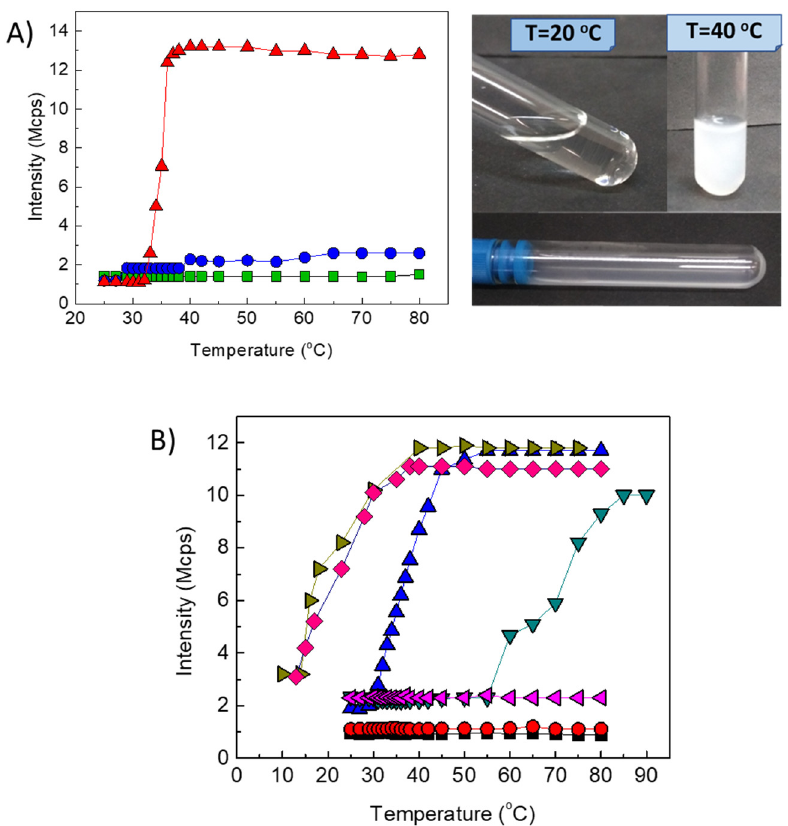
Figure 3. Light scattering intensity at 90 o as a function of temperature of PLL-g-NIPAm69 in aqueous solutions of various pH: ( A ) ( ∆ ) pH 11.8, ( ○ ) pH 9.5, ( □ ) pH 8.3, the photo illustrates a transparent solution at pH 11.8, at 20 °C and a cloudy one at 40 °C, which flows as a liquid (lowest image), and ( B ) in the presence of NaCl at various pH: 1M NaCl, pH ( □ )7.5, ( ○ ) pH 8,5, ( ◁ ) pH 9.1, ( ∆ ) pH 9.6, ( ▷ ) 9.8 and ( ∇ ) pH 9.0, 1.5M NaCl, ( ◊ ) pH 8.8, 2M NaCl.